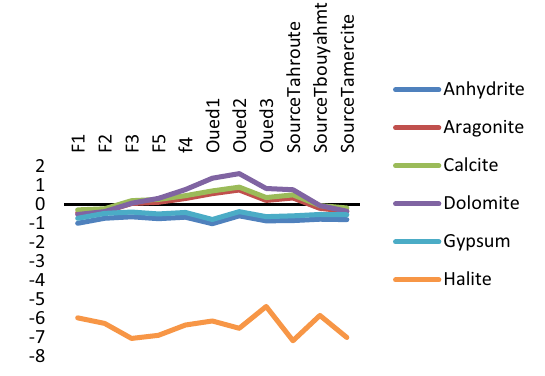
Fig. 7 Saturation index variation of